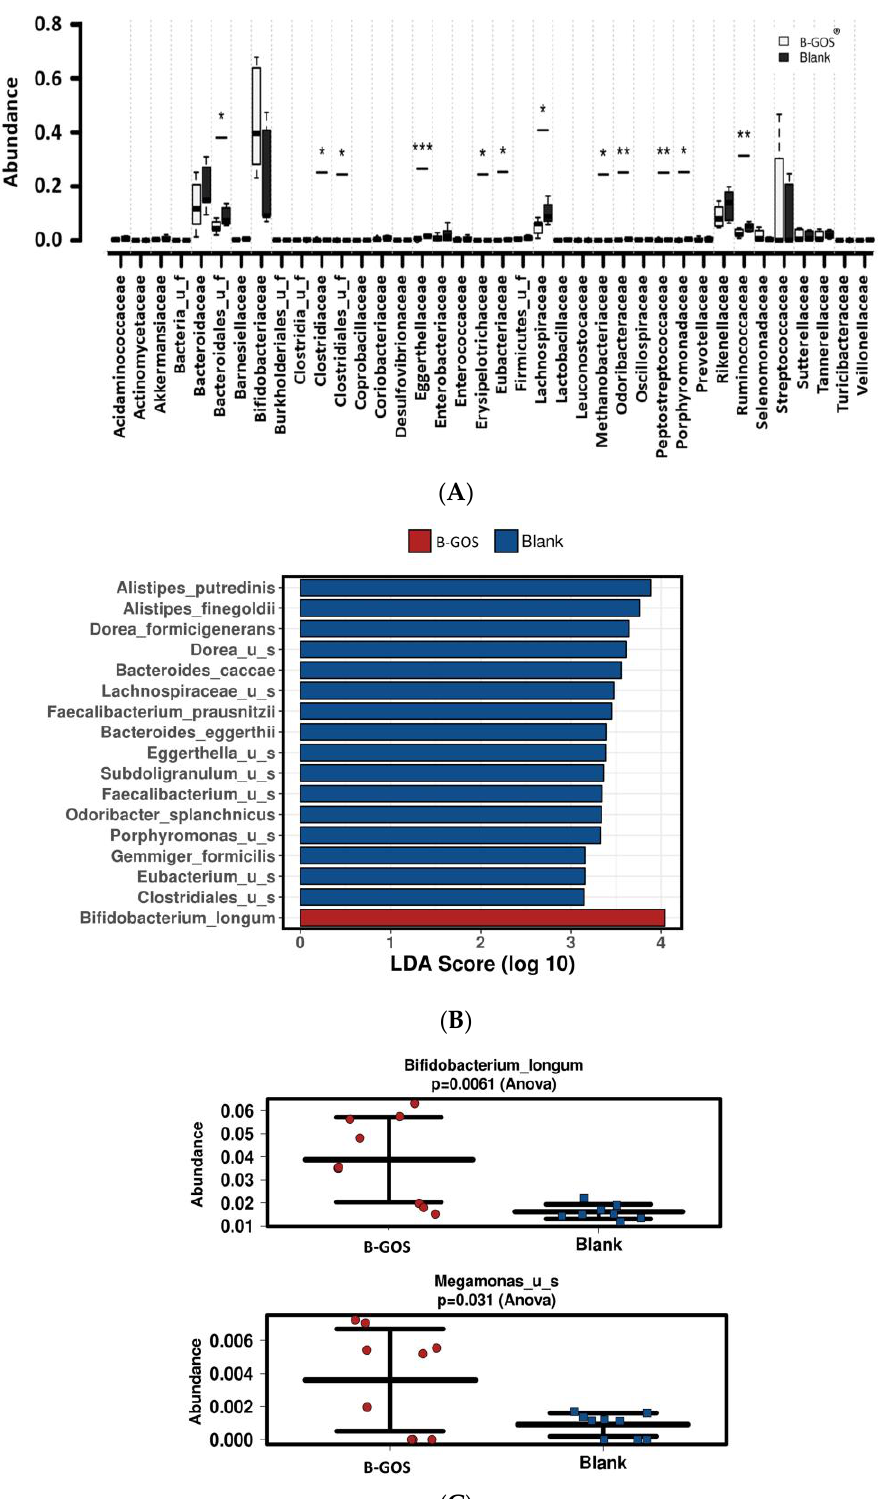
Figure 5. Changes in the microbial community composition ( a ) relative abundance (family level) 6 h after treatment, ( b ) linear discriminant analysis effect size of relative abundances (species level) 6 h after treatment, ( c ) boxplots for the most important enrichments (species level) 6 h after treatment. *: p < 0.05, **: p < 0.01, ***: p < 0.001. GOS = Bimuno ® galactooligosaccharide; LDA = linear discriminant analysis.